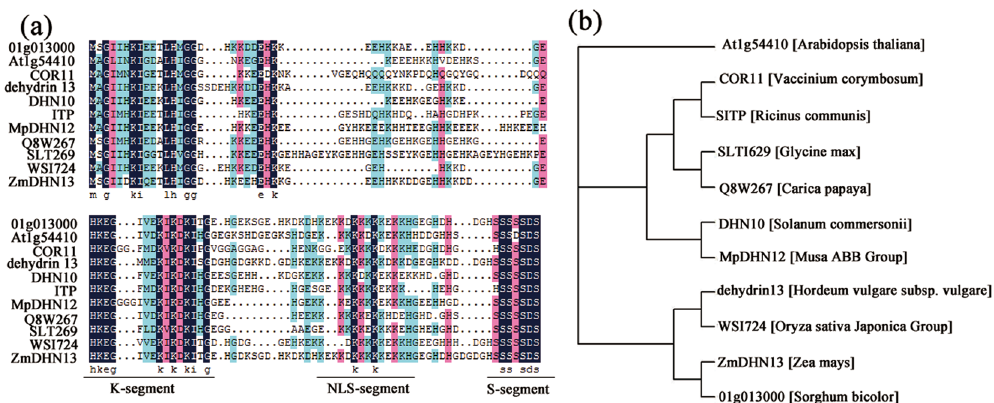
Figure 2. Sequence analysis of ZmDHN13 derived from maize and multiple sequence alignment and analysis of KS-type dehydrins from several plant species. ( a ) Multiple sequence alignment of ZmDHN13 with other KS-type dehydrin proteins. ( b ) Phylogenetic relationship of ZmDHN13 with other closely related LEA proteins. The unrooted dendrogram was constructed with the Tree View tool using the maximum likelihood method based on a complete protein sequence alignment of LEA proteins from other